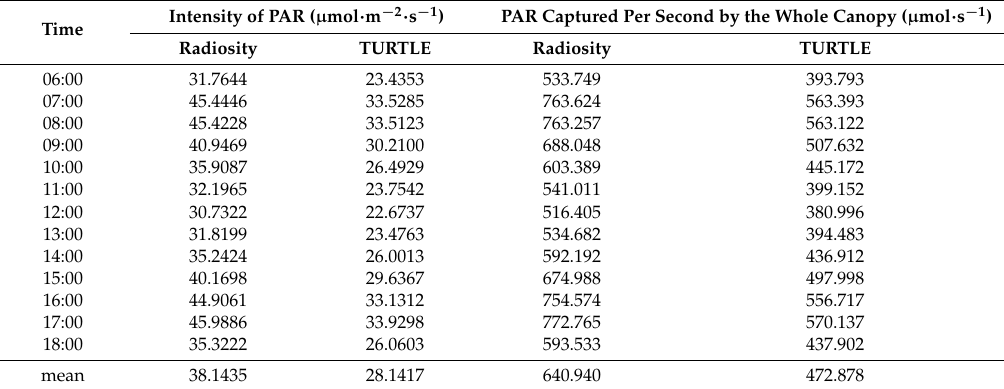
Table 3. Comparison of diffuse sky PAR parameters simulated hourly based on radiosity and the TURTLE algorithm within the loquat canopy.